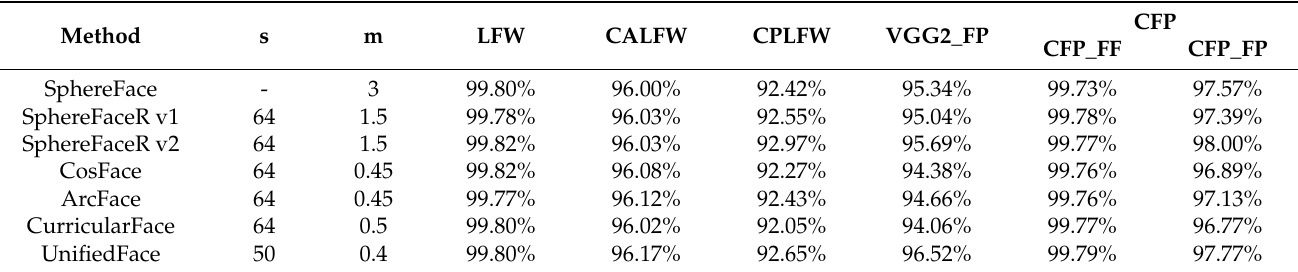
Table 8. Performance comparison of UnifiedFace with state-of-the-art methods in using MS1M V3 as the training dataset.